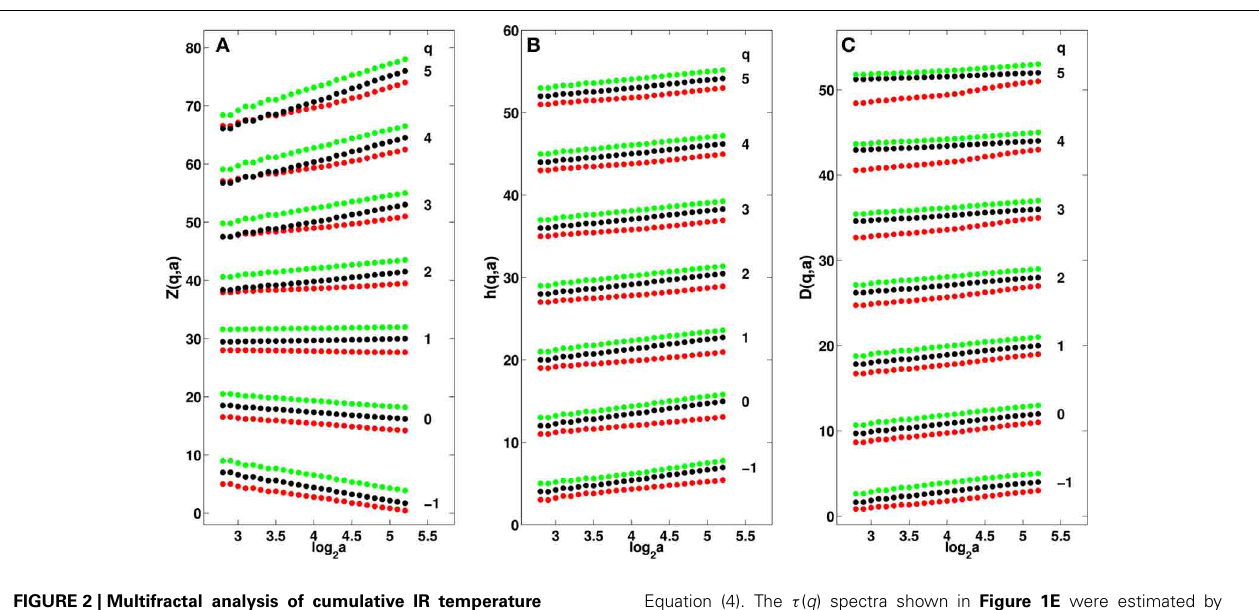
Equation (4). The τ ( q ) spectra shown in Figure 1E were estimated by linear regression fit of the data in (A) over the range 2 . 8 (cid:2) log 2 a (cid:2) 5 . 2. The D ( h ) spectra in Figure 1F were obtained by linear regression fit in (B,C) over the same range of time-scales. The analyzing wavelet is ψ (2)